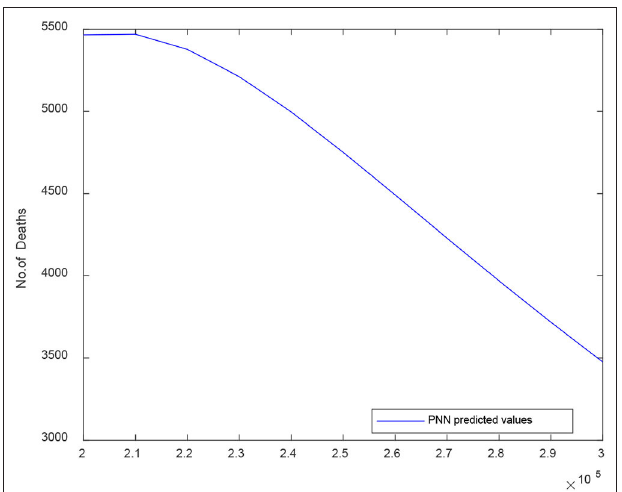
FIGURE 9 | Predicted curve for D2 using PNN.